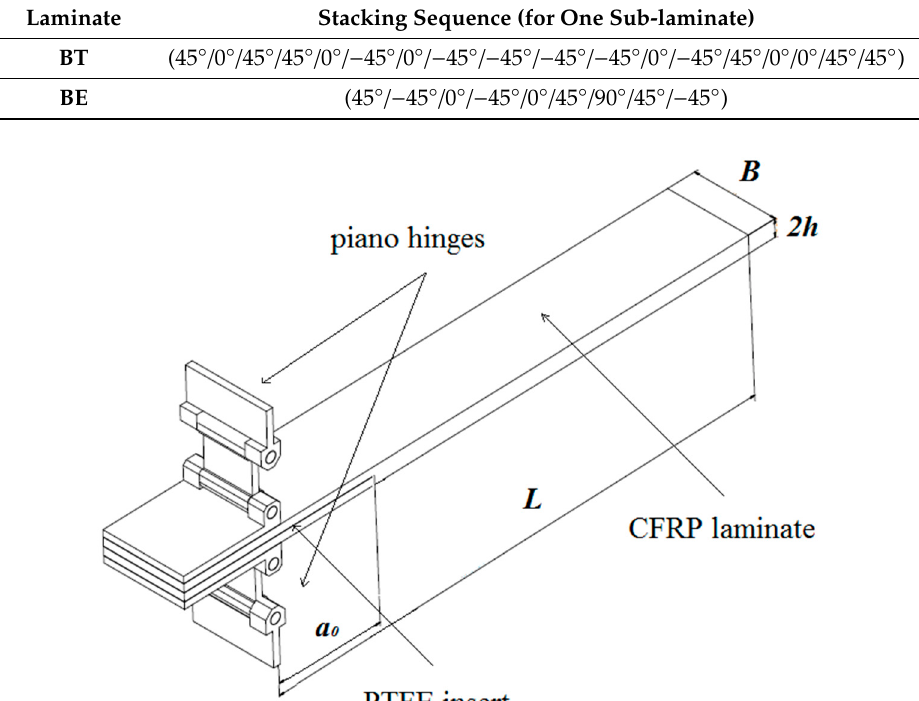
Table 1. Laminate configurations.